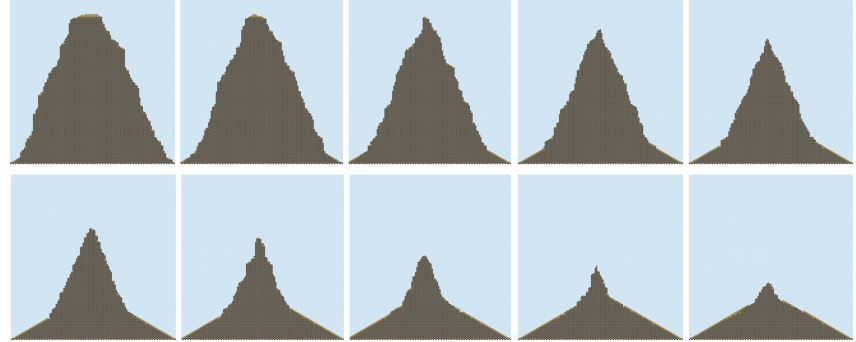
Figure 17. Time series showing transient erosion of a steep rock slope under a stable base-level, highlighting formation of ramp-and-cliff morphology. Simulation shows 20000 years of slope evolution under d = w = 10 − 3 yr − 1 . Nominal width, assuming δ = 0 . 1m, is 12m.